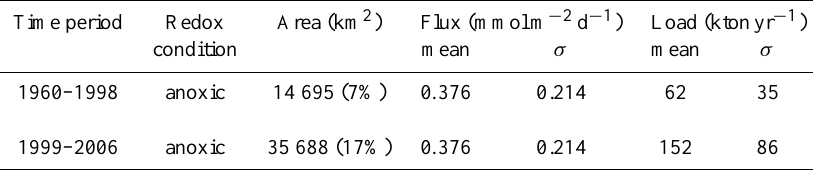
Table 3. Calculated internal DIP load to the Baltic Proper, based on in situ measured benthic DIP fluxes (this study) and the areal extent of anoxia based on the data from Hansson et al. (2011) for the two time periods 1999–2006 and 1960–1998 and recalculated for only the Baltic